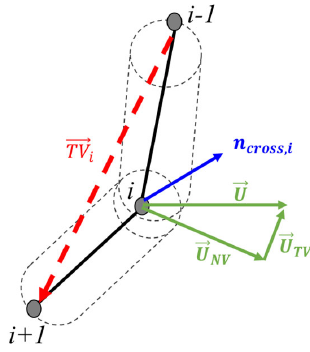
→ U NV , i and unit vector normal to